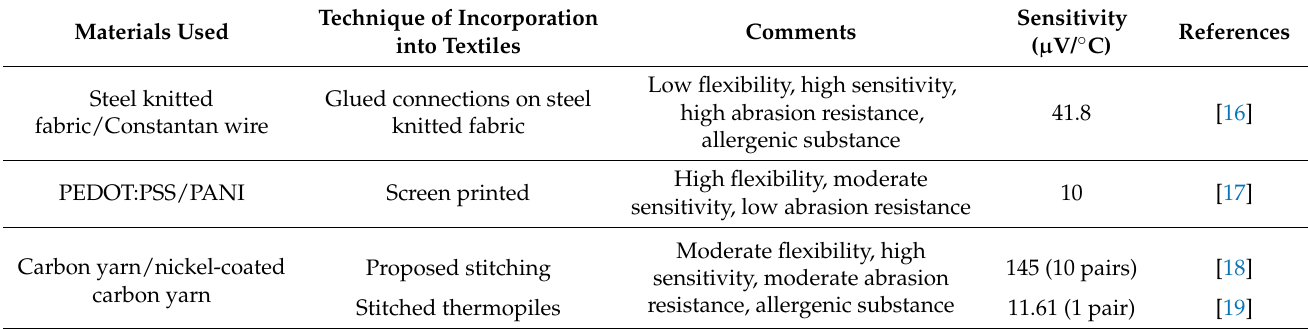
Table 2. Comparison to relevant literature on the manufacture of textile-based thermocouples.